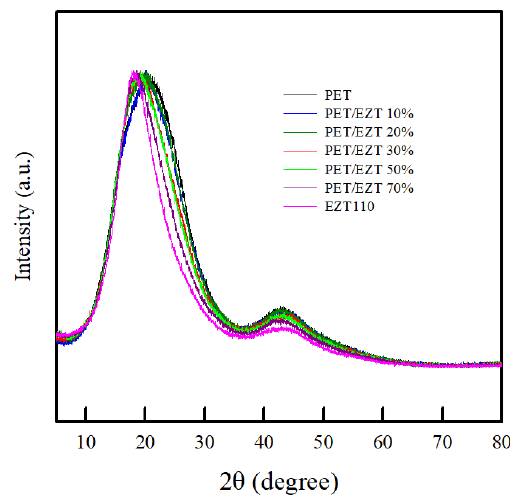
Figure 6. XRD patterns of the PET/EZT samples.